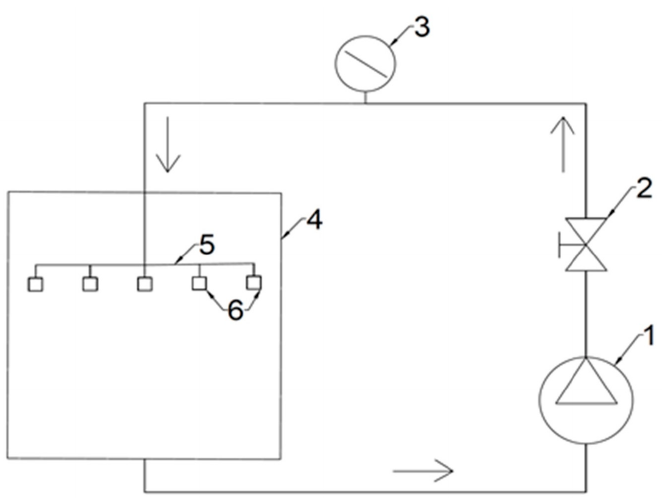
Figure 2. Schematic diagram of the accelerated wear test device: 1—pump, 2—pressure regulator, 3—pressure gauge, 4—tank, 5—nozzle holder, 6—nozzles. After each wear interval, the flow rate measurements were done using a specific measuring device from ITEQ, Wallonia-Belgium. This device assesses the flow rate (quan- sprayer boom [21]. Tap water with a 21 °C temperature and at 3.0 bar pressure was used. The measurement for every nozzle of the six nozzle samples was replicated three times.